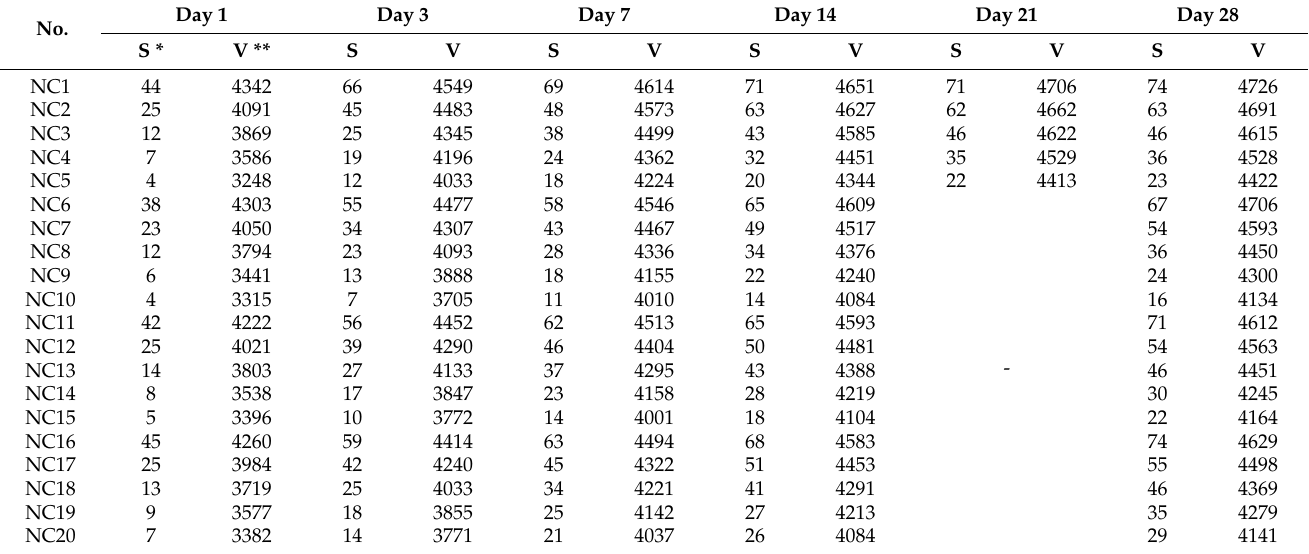
Table 5. The measured UPV and strength data for normal concrete.